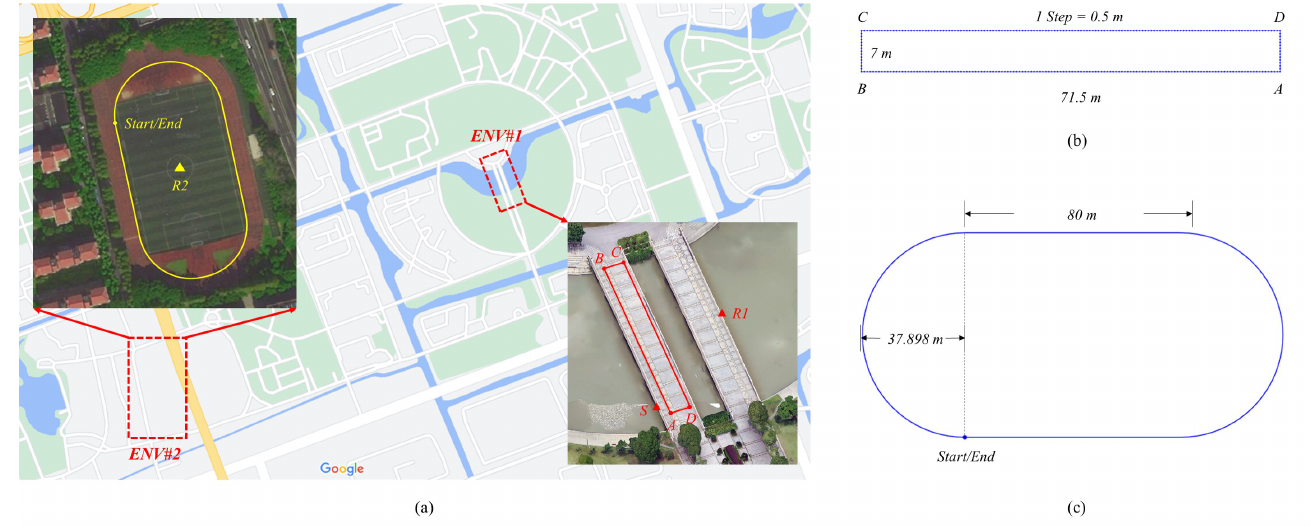
Figure 4. Experimental environments. ( a ) Two test sites. ( b ) The track used for control point test. ( c ) The track used for GNSS/PDR fusion test.